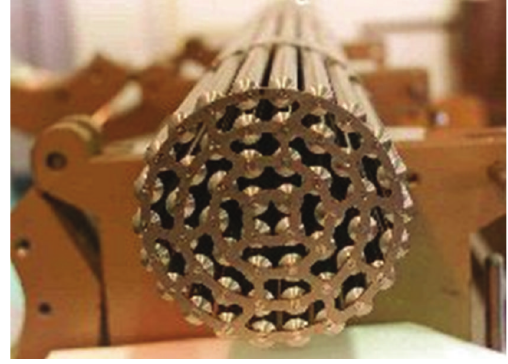
Figure 1: CARA Fuel.